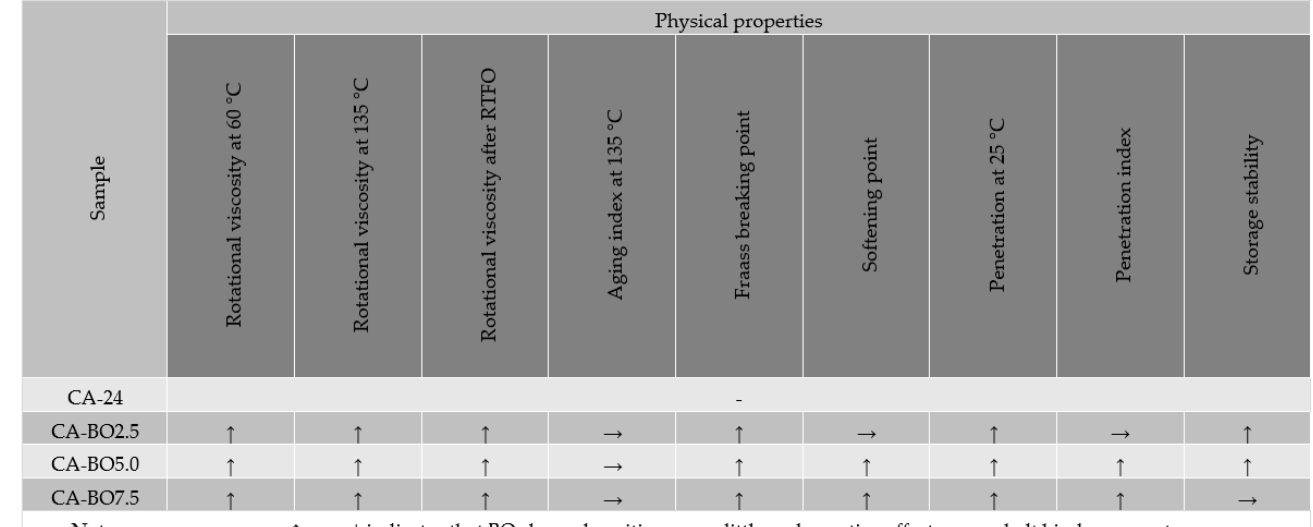
Figure 13. Summary of the effects of BO on the physical properties of asphalt binder.